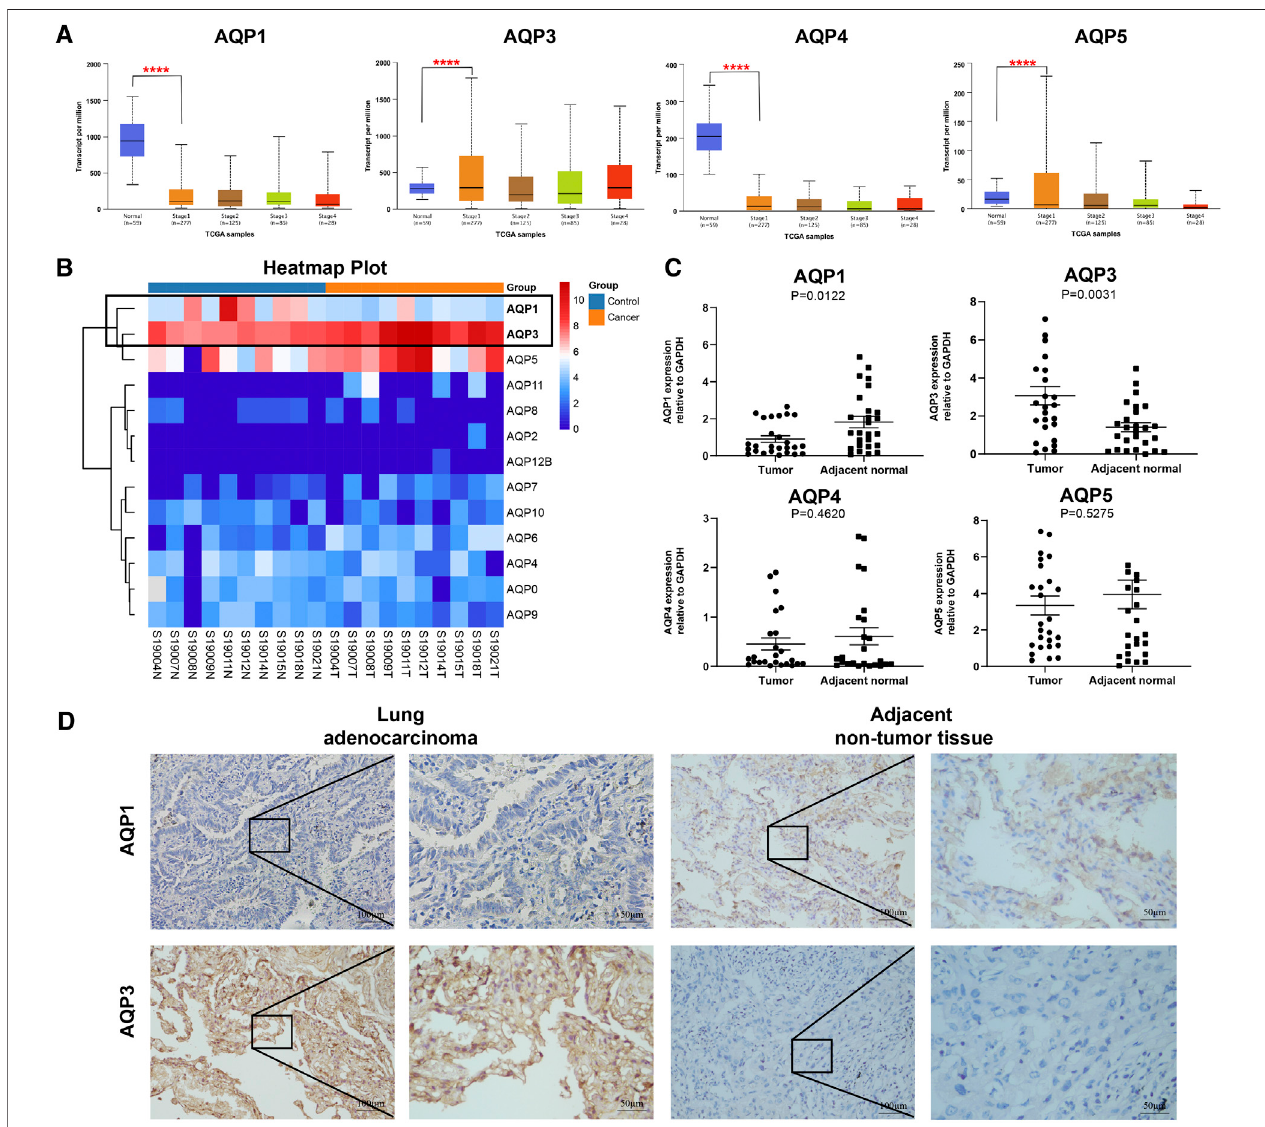
FIGURE2| GeneexpressionofAQPsfamilymembersinLUADpatients. (A) AQPexpressioninLUADpatientsatdifferentclinicalstagesaccordingtoUALCAN. (B) Heat maps of AQP expression pro fi les identi fi ed in pulmonary normal and cancer tissues. (C) The mRNA expression of AQPs in LUAD tissues compared with adjacent normal tissues by RT-PCR ( n (cid:1) 28). (D) The protein expressions of AQP1 and AQP3 in stage I LUAD tissues compared with adjacent normal tissues via IHC ( n (cid:1) 9). (**** p < 0.0001).